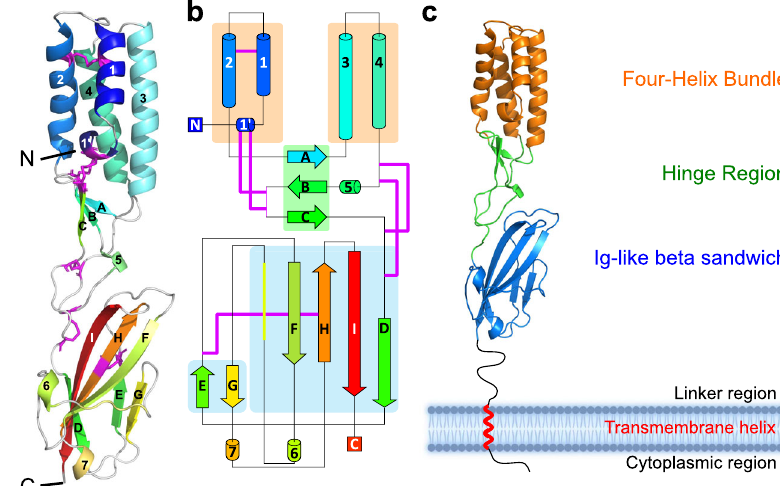
Fig. 1 SPACA6 contains two distinct domains. a Structure of the SPACA6 ectodomain. Ribbon diagram of the SPACA6 ectodomain, with the chain from the N to C termini colored from dark blue to dark red. Cysteines involved in disul fi de bonds are colored magenta. b Topology diagram of SPACA6 ectodomain. The same color scheme is used as Fig. 1a. c Domains of the SPACA6 ectodomain. Ribbon diagram with the 4HB, hinge, and Ig-like domains colored orange, green, and blue, respectively. The membrane layer is not drawn to scale.